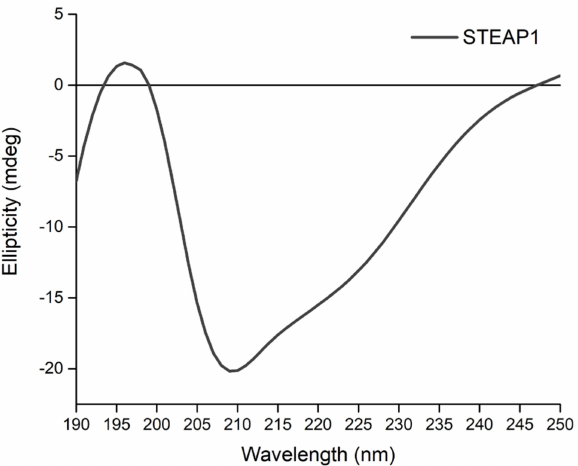
Figure 6. Representative CD spectrum of secondary structure of STEAP1 in 10 mM Tris-HCl, pH 7.8 buffer showing a minimum and a maximum peak at 209 and 196 nm,